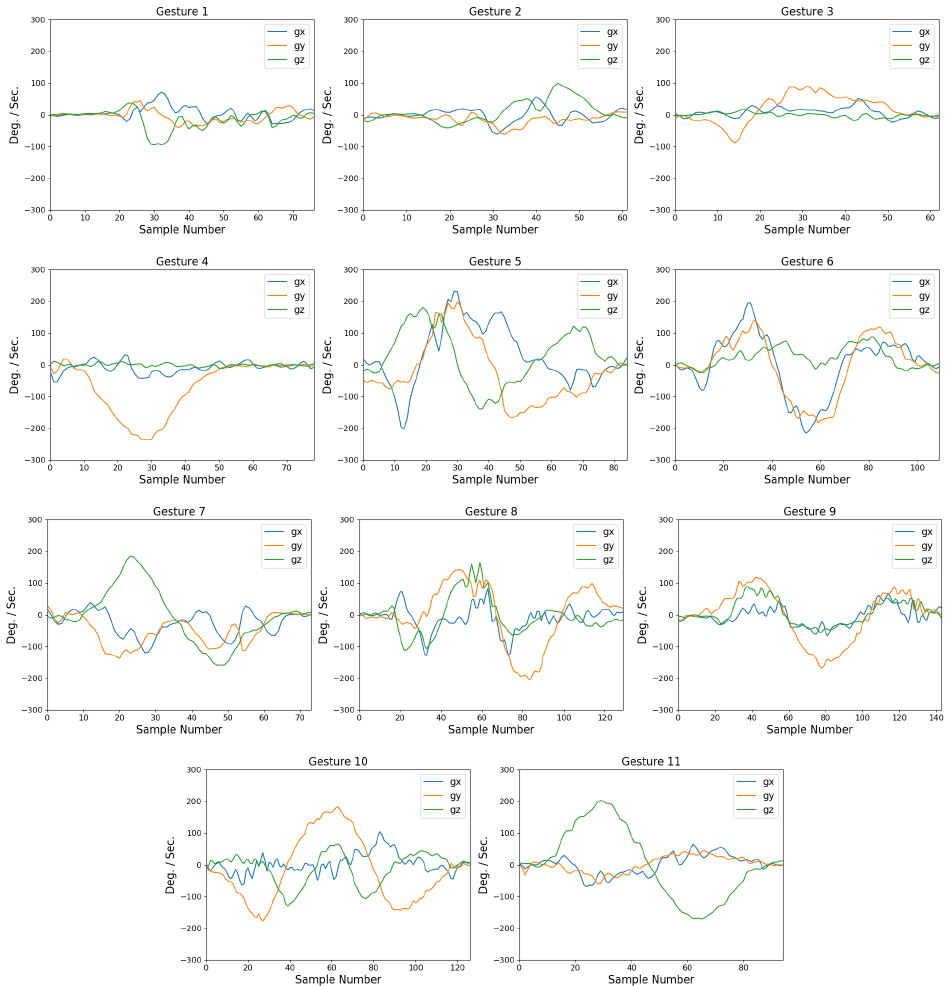
Figure 13. Samples of waveforms produced by gyroscopes in three axes (gx, gy, and gz) for each